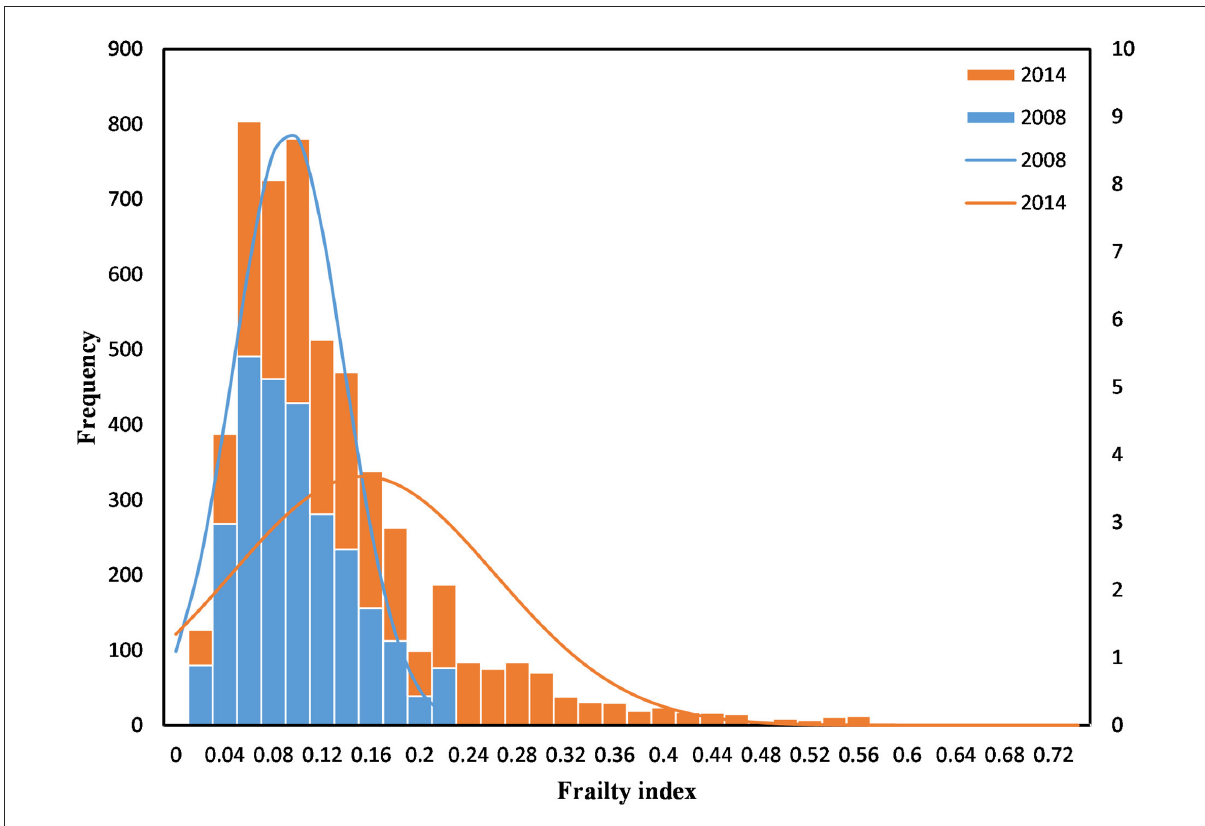
FIGURE2 Histogram of the frailty